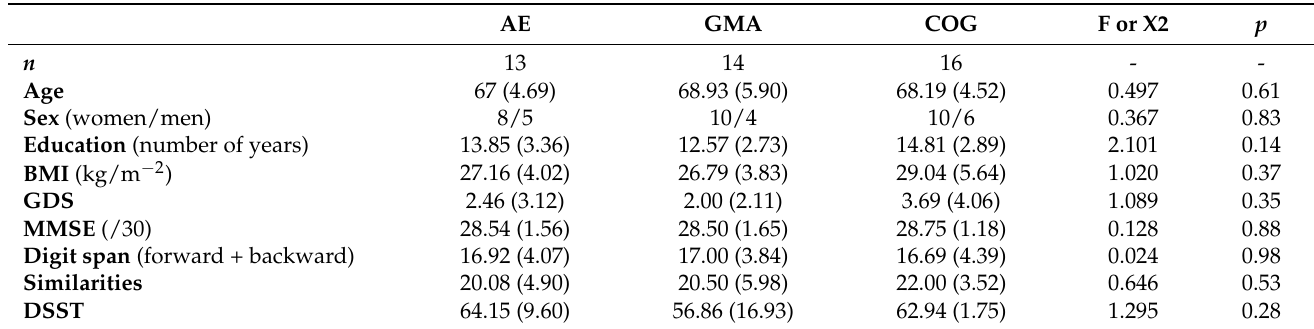
Table 1. Baseline